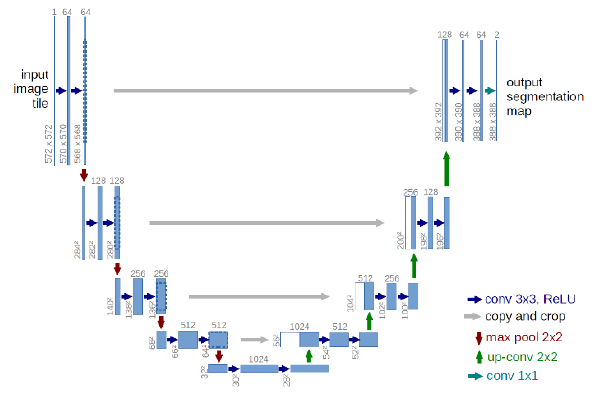
Figure 1 . U-Net architecture (Ronneberger et al., 2015).